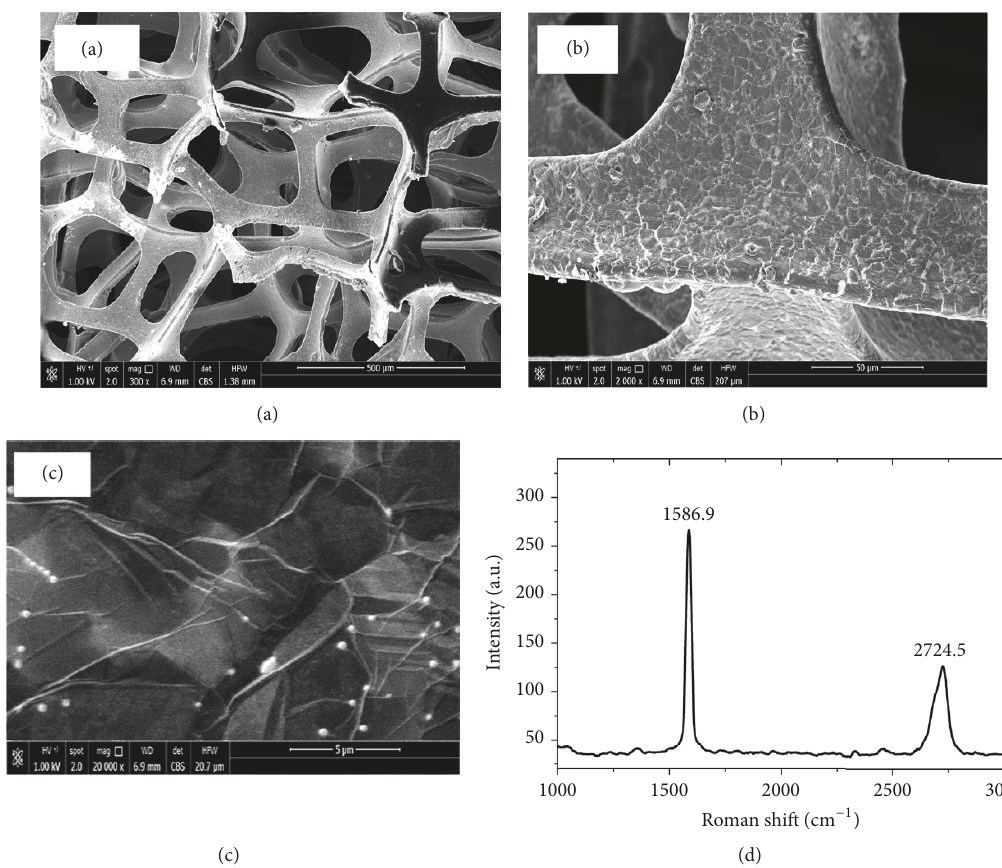
Figure 5: Characterization of graphene foam: (a–c) represent the morphology of foam using SEM and (d) depicts Raman spectra of 3D graphene